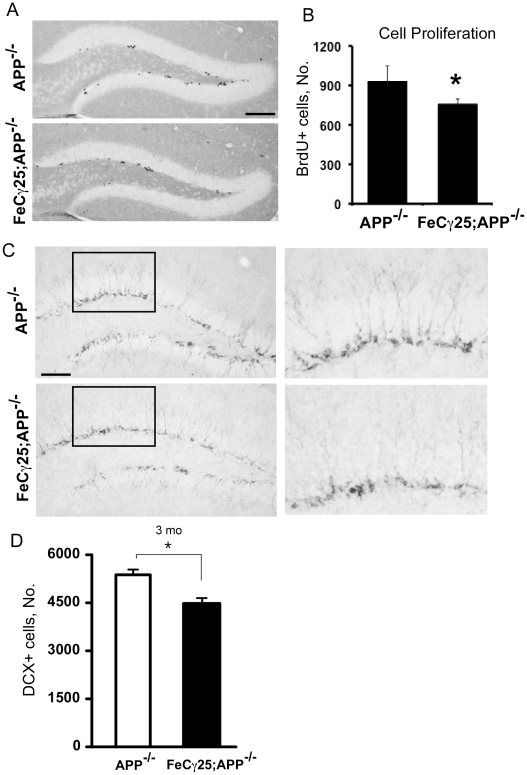
The effect of AICD is independent of other APP metabolites including Aβ.
A–B, Decreased cell proliferation in FeCγ25;APP−/− mice compared to APP−/− mice. Photomicrograph reveals a reduced number of BrdU+ cells in the SGZ of FeCγ25;APP−/− compared to APP−/− which is quantified in (B) throughout the entire rostro-caudal extent of hippocampus. C, There was also a decrease in the number of immature neurons (DCX+) in the FeCγ25;APP−/− mice compared to APP−/−. Insets are magnified on the right to reveal the decreased number of DCX+ cells and the resulting dendritic branches in comparable regions of the hippocampus. (D) Quantitative analysis of the total number of DCX+ cells throughout the entire rostro-caudal extent of the hippocampus in 3-month-old animals reveal a statistically significant decrease in the number of DCX+ cells in the SGZ of FeCγ25; APP−/− mice compared to APP−/−mice.* p<0.05 (Student's T-test). n = 3 for all.